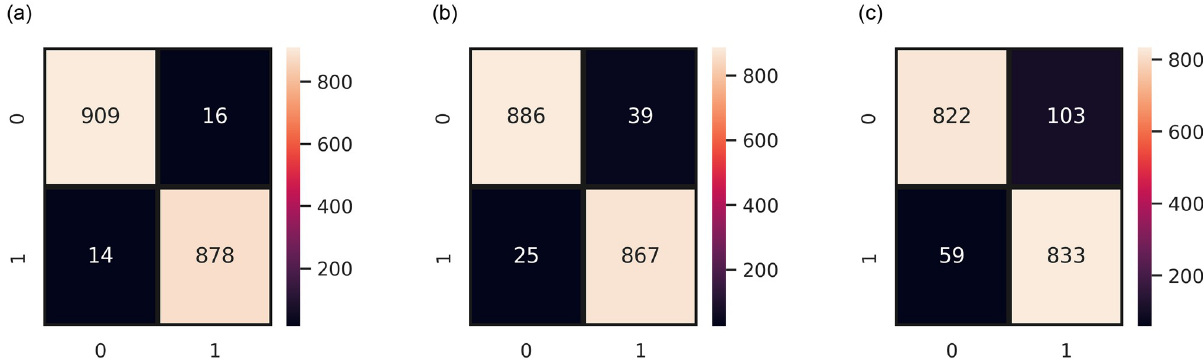
Fig 11. Confusion matrix of ER-VC concerning binary classification on SMOTE-balanced data, (a) ER-VC with TF-IDF, (b) ER-VC with BoW, and (c) RT-VC with GloVe.